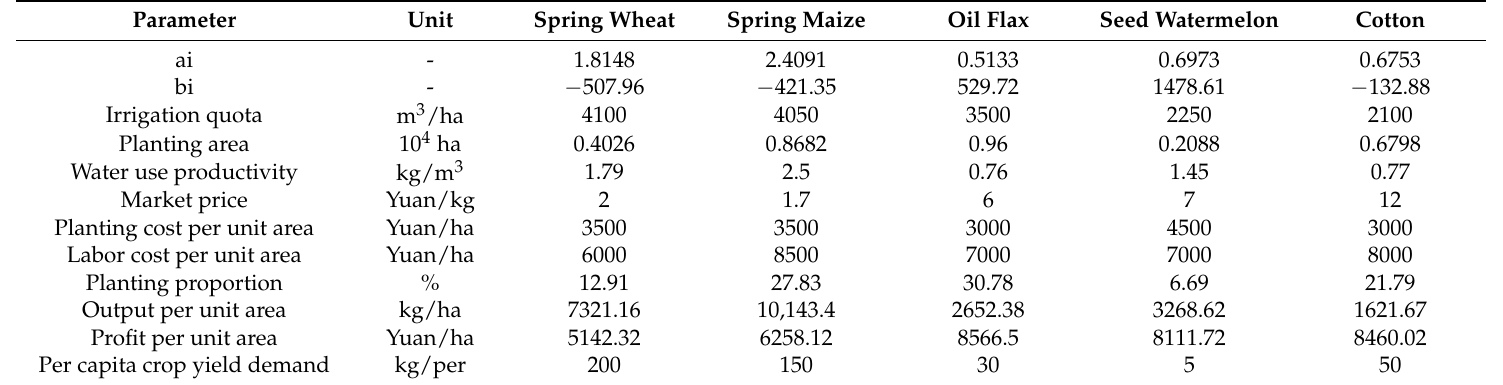
Table 1. Basic data for typical crops in Hongyashan irrigation district.